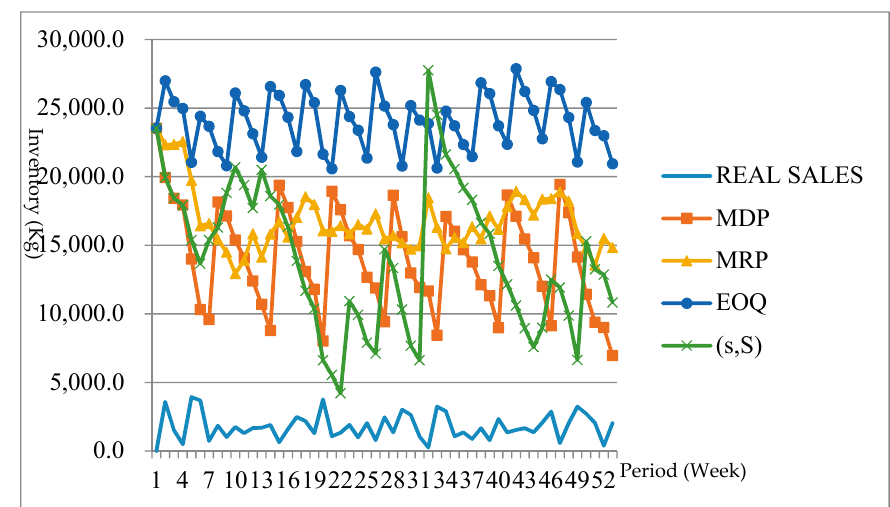
Figure 2. Inventory charts (period 165 to 216).